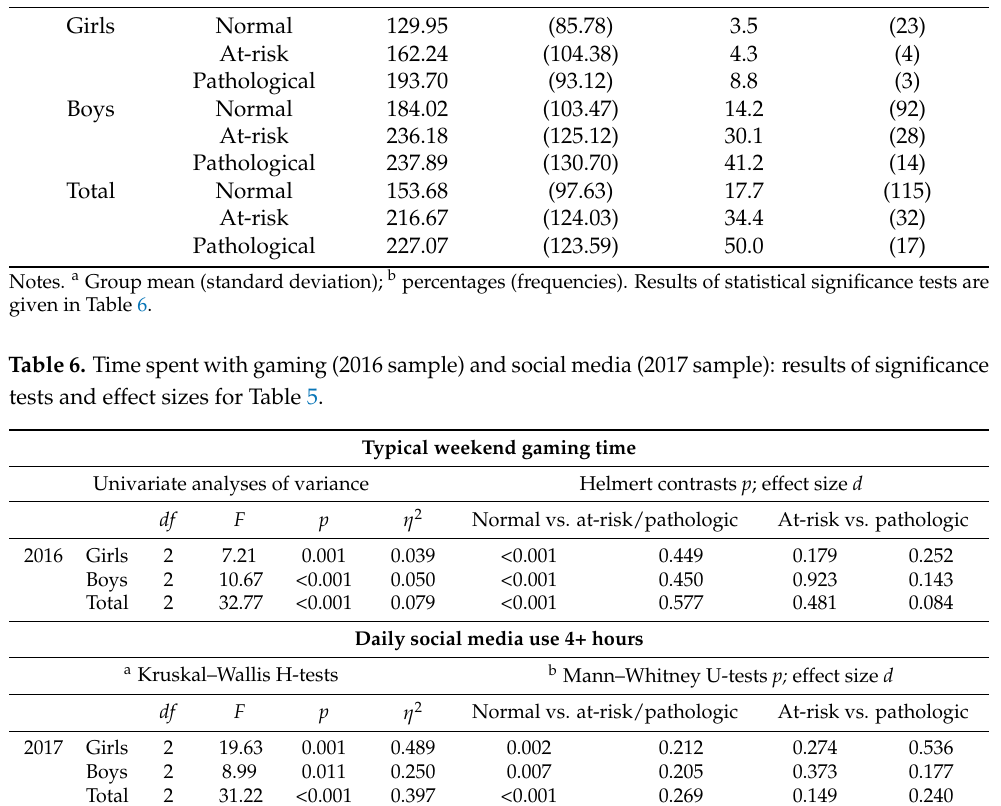
Table 7. Distribution of Strength and Difficulties Questionnaire (SDQ) subscales in the 2018 sample, depending on IGDS score. Sex IGDS Score